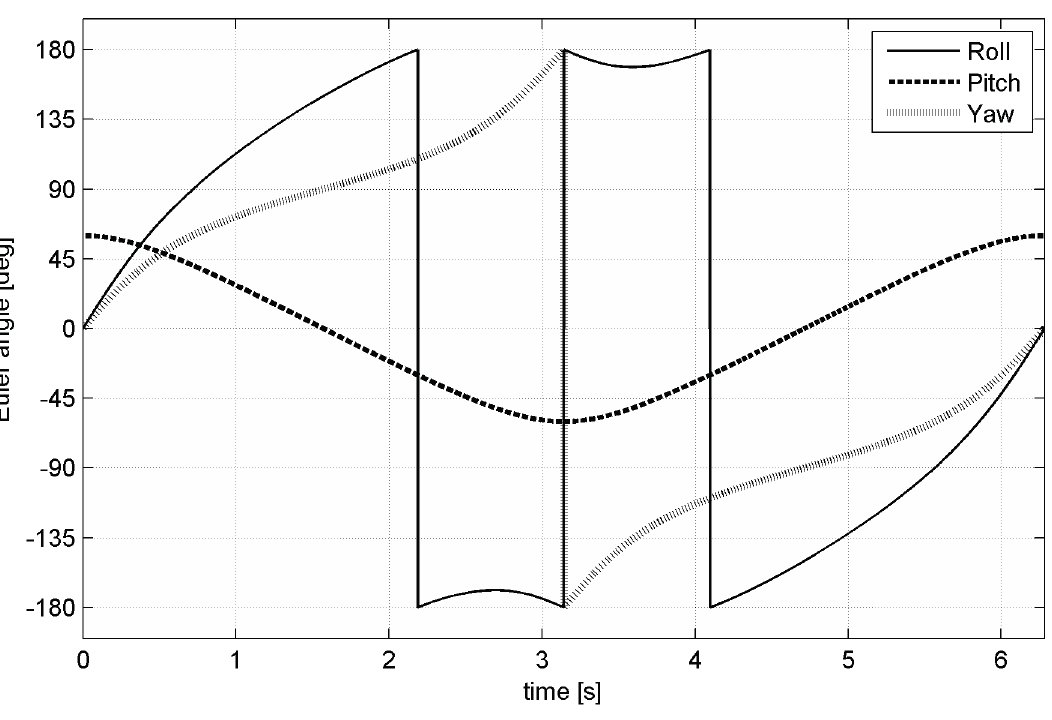
Figure 5. Euler angles during one turn of the simulated